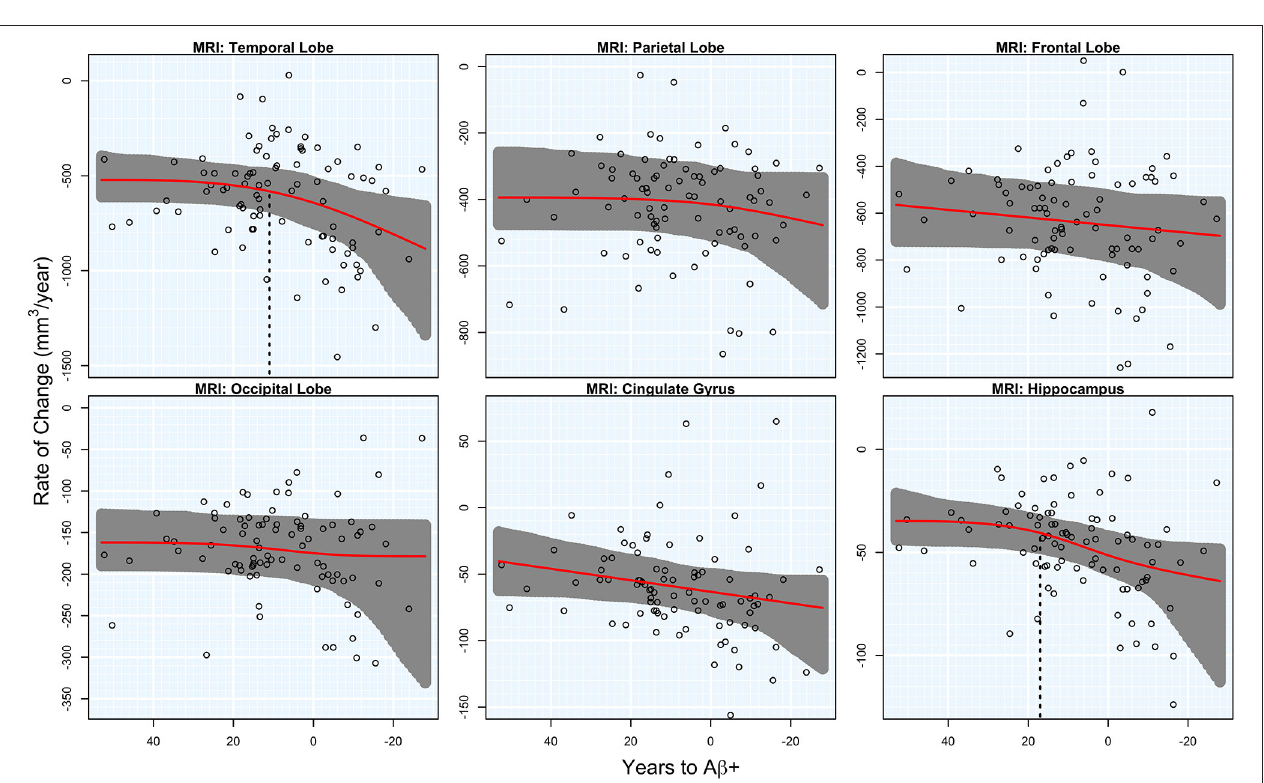
FIGURE 2 | FDG rates of change. Annual rates of change for FDG PET are plotted against T2A β + . Rates worsen from top to bottom and time to A β -positivity decreases from left to right. Estimated curves are in red with 95% confidence intervals shaded in gray. The vertical dashed line in black is the estimate of the initial acceleration point.